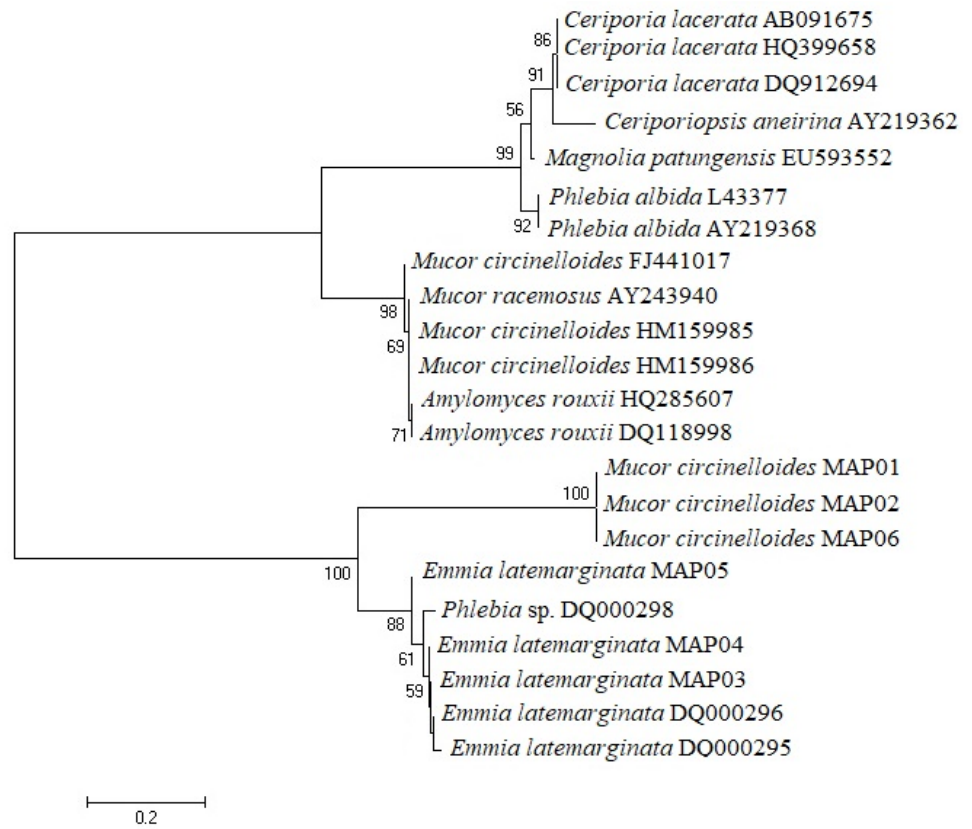
Figure 2. Molecular phylogenetic analysis of fungal isolates. The numbers at the nodes indicate the levels of bootstrap support based on Kimura distance and the neighbour-joining method.